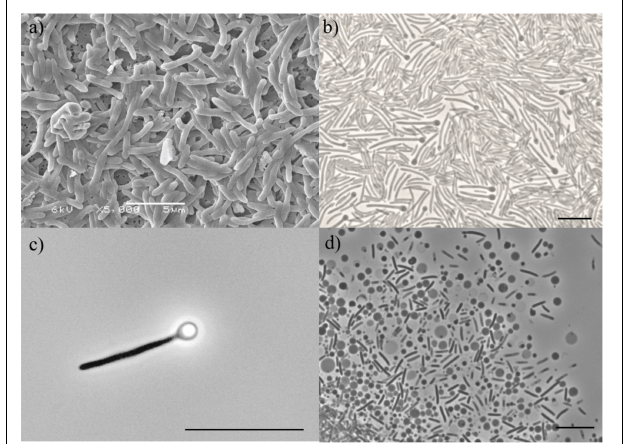
FIGURE 2 | (a) Scanning electron microscopy image of cells of strain ALE T ; Bar represents 5 µ m. Phase-contrast microphotographs of (b) vegetative, (c) spore-forming cell with refractive sporangia in terminal position, and (d) vesicles of strain ALE T . Bar represents 2 µ m.